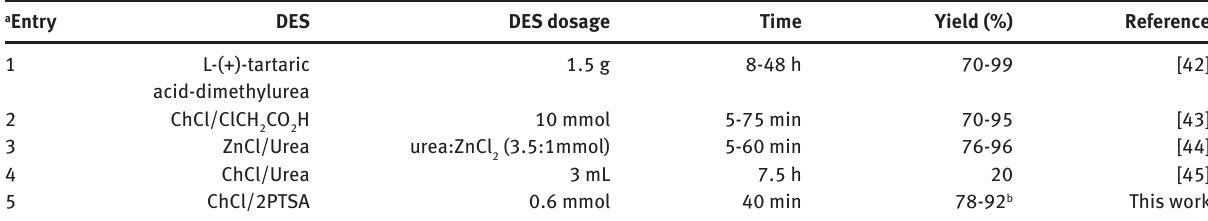
Table 3: Synthesis of DHPMs using different DESs